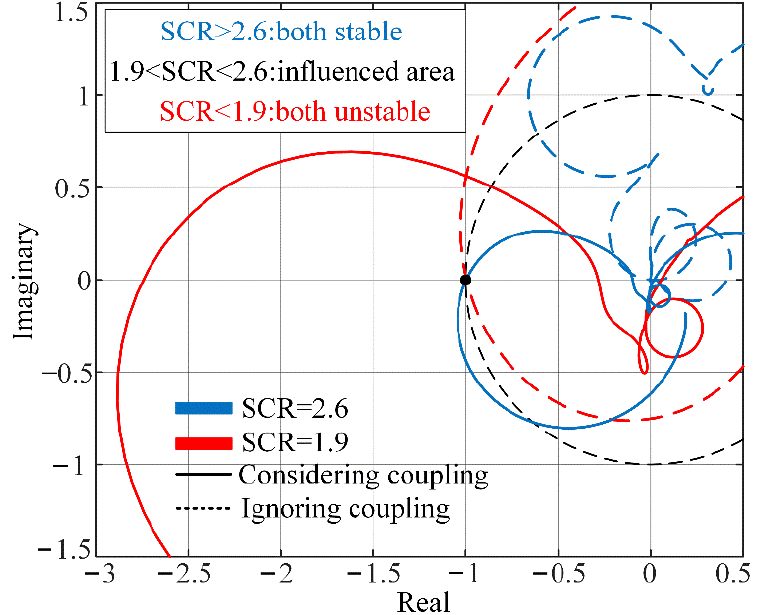
Figure 12. Nyquist plot of the impedance ratio Z g ( s ) Y MMC ( s ) with the phase current controller. Figure 13 shows the time-domain simulation results of the MMC under a step change of the grid condition, where only the phase current controller is adopted. The parameters in the simulation are the same as those in Table 2. It can be seen that the system is stable when SCR = 2.7. However, the grid-connected MMC loses stability as SCR = 2.5, which is consistent with the theoretical analysis in Figure 12. The dominant oscillation frequency is around 18 and 82 Hz. It is the coupling effect that causes both the sub- and super-synchronous frequency in the